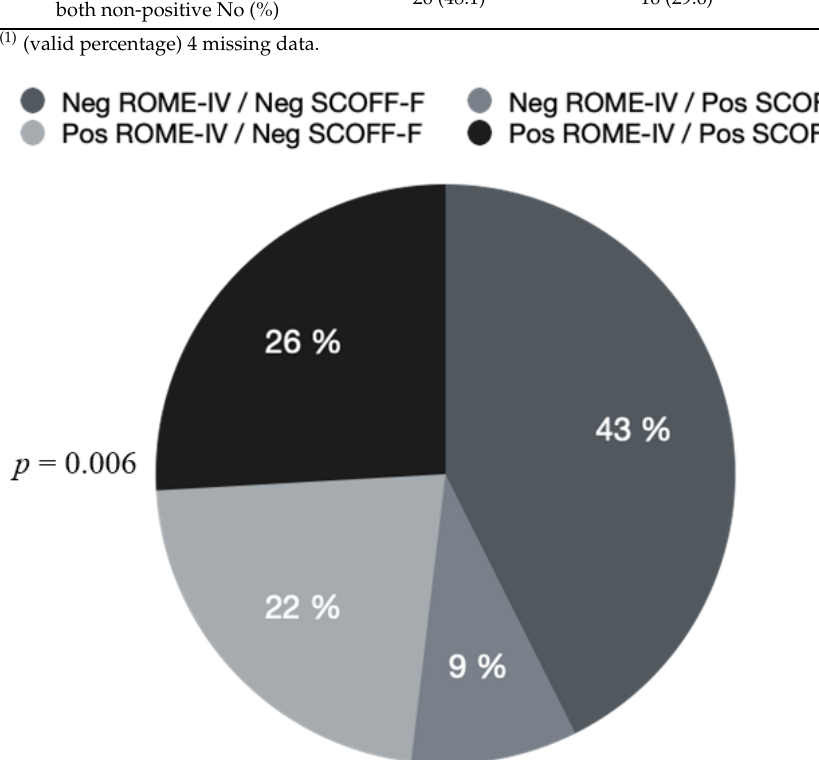
Figure 2. SCOFF-F and ROME-IV scores in the 54 responding patients. SCOFF-F: Sick, Control, One, Fat, Food-French version score; Neg ROME-IV: Negative ROME-IV; Neg SCOFF-F: Negative SCOFF-F; Pos ROME-IV: Positive ROME-IV; Pos SCOFF-F: Positive SCOFF-F. We performed the same tests with the SCOFF-F score, and only the HAD-Anxiety variable was significantly different according to the response to the SCOFF-F score (Table